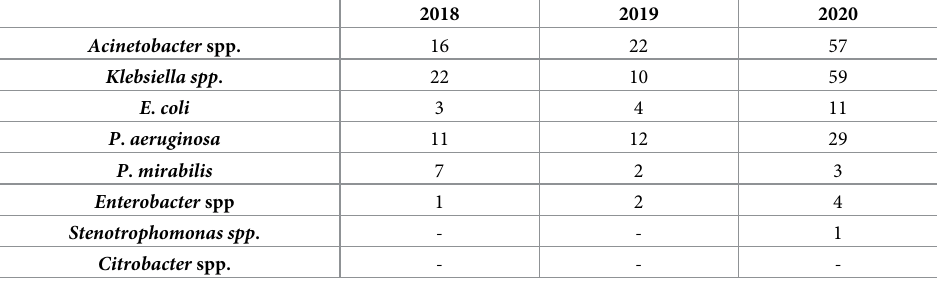
Table 6. The frequency of MDR in